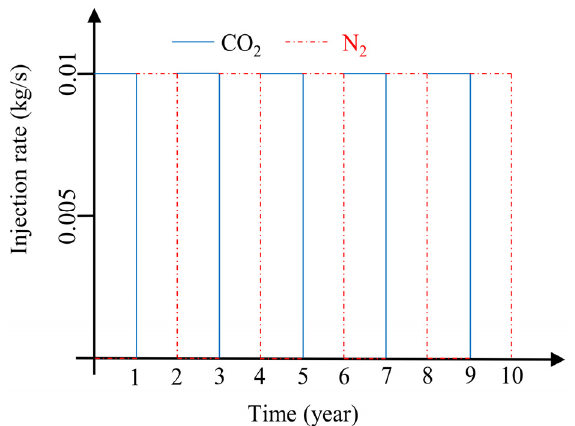
Energies 2022 , 15 , x FOR PEER REVIEW Figure 17. Carbon dioxide and nitrogen injection rate and cycle. Figure 17. Carbon dioxide and nitrogen injection rate and cycle.